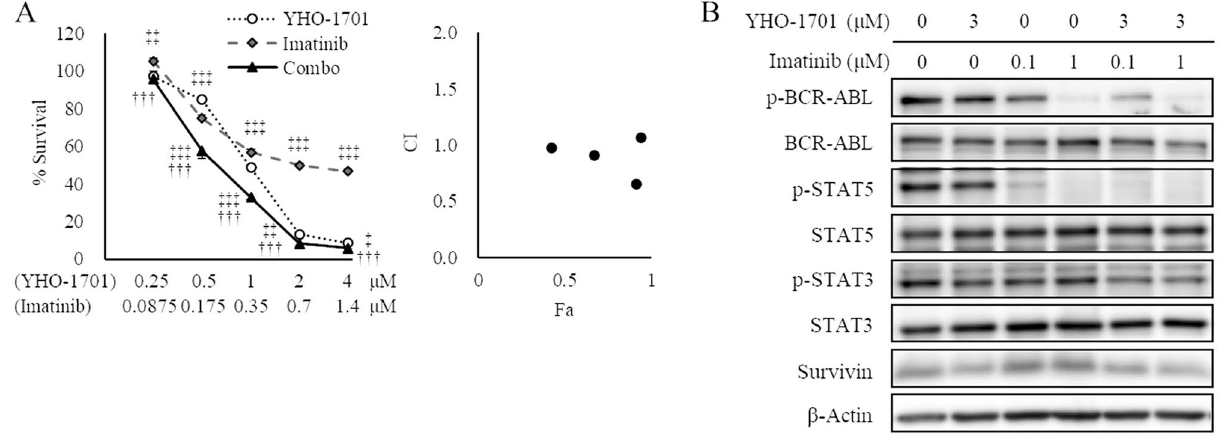
Figure 3. Synergism between YHO-1701 and imatinib in SUP-B15 cells. ( A ) The antiproliferative effect of YHO-1701 and/or imatinib was evaluated at 72 h of exposure. Dose–response curves are shown in the left panel. Combination index (CI) values are plotted as a function of fraction affected (Fa) in the right panel. Significance was determined with Tukey’s test. ††† p < 0.001 versus the imatinib group. ‡ p < 0.05; ‡‡ p < 0.01; and ‡‡‡ p < 0.001 versus the YHO-1701 group. ( B ) Phosphorylation/activation patterns of crucial molecules on BCR-ABL and STAT3 signaling pathways were analyzed by western blotting. SUP-B15 cells were left untreated or treated with YHO-1701 and/or imatinib at the indicated doses for 24 h. The blots were probed with primary antibodies specific for the target proteins. Images were cropped for clarity, and full-length blots are presented in Supplementary Fig. S3.